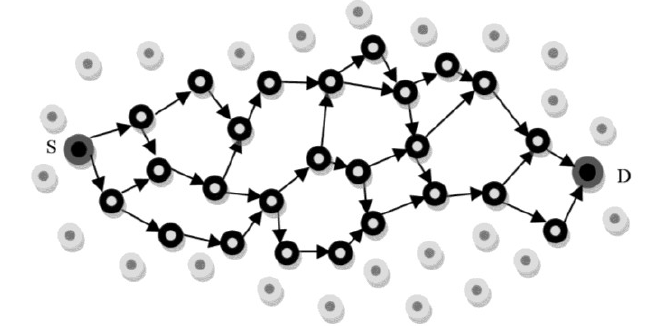
Figure 5. A source-to-destination meshed multipath